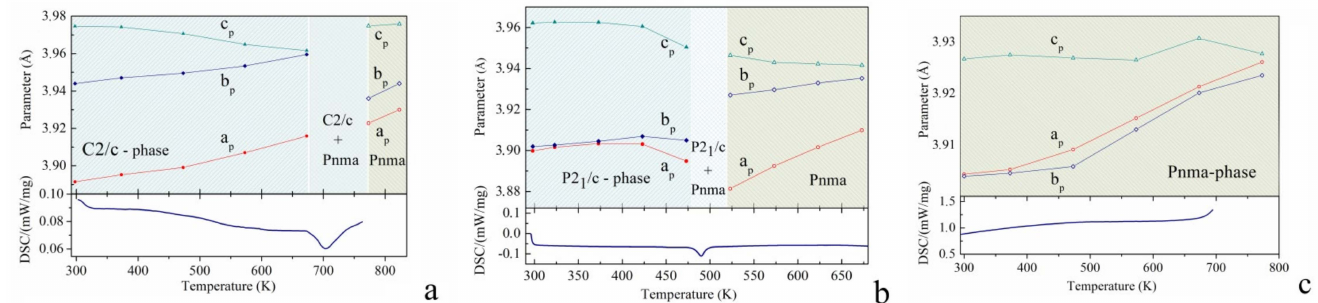
Figure 4. The unit cell parameters derived from the SPD and NPD data of the compounds BiMnO 3+ δ with δ = 0.02, 0.08, 0.14 - ( a – c ), respectively. The DSC curves obtained for the respective compounds are presented at the bottom. The unit cell parameters are presented in normalized form, viz. a p = a/ √ √ a p = a/ 2, b p = b/4, c p = c/(2 2) · (for Pnma